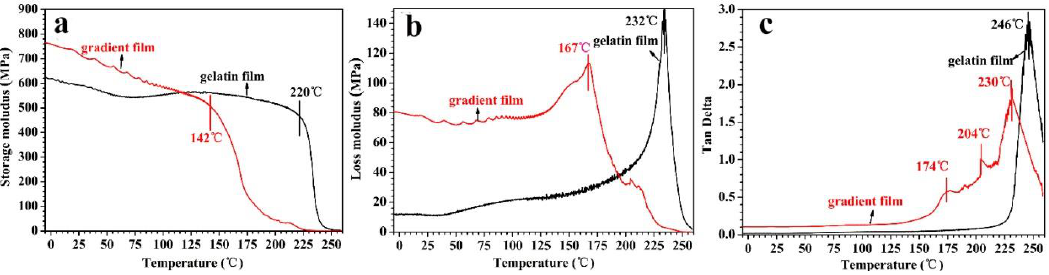
Figure 8. ( a ) Storage-moduli, ( b ) loss-moduli, and ( c ) tan delta values of the gradient and gelatin films, measured by DMA in the tensile mode.